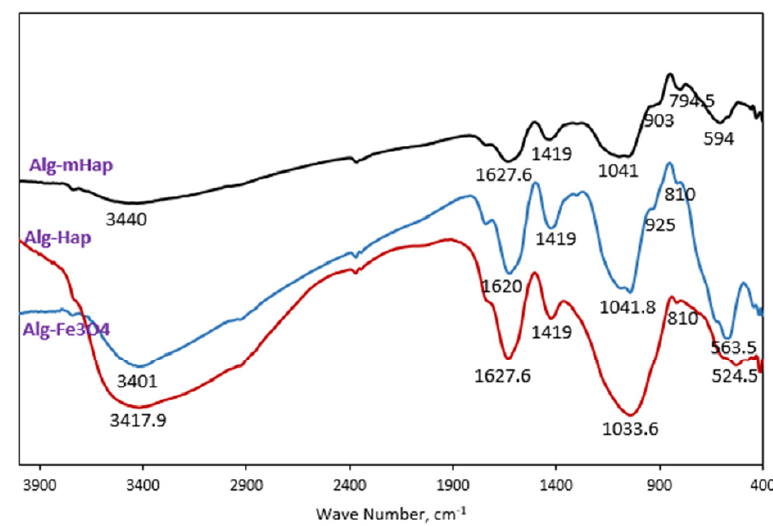
Fig. 1. FTIR analysis of Alg-Hap, Alg-Fe